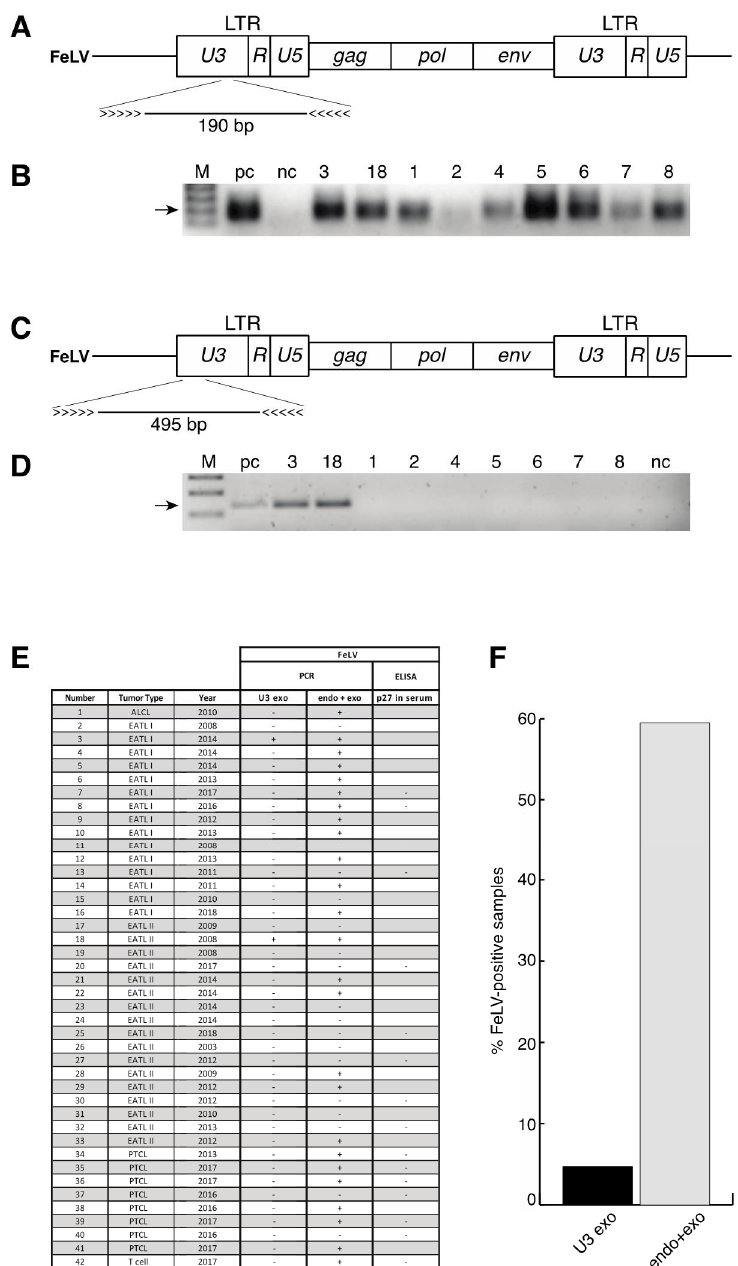
Figure 6. No accumulation of active FeLV among tumour samples. ( A ) Scheme of FeLV structure and location of the primers in the U3 region used for detection of endogenous and exogenous virus sequences. ( B ) Representative images of amplifications of FeLV sequences using primers shown in ( A ). pc = positive control (tissue from a feline patient that was tested positive for FeLV p27 by ELISA) nc = negative control (tissue from a feline patient that was tested negative for FeLV p27 by ELISA) ( C ) Scheme of FeLV structure and location of the primers in the U3 region used for detection of exogenous virus sequences. ( D ) Representative images of amplifications of FeLV sequences using primers shown in ( C ). pc and nc as in ( B ). ( E ) Table summarising the results from the PCR analysis and ELISA. U3 exo corresponds to the detection of exogenous FeLV sequences as in ( C , D ), endo + exo to the detection of endogenous and exogenous sequences as in ( A , B ). The status of p27 was detected in the serum of patients by ELISA as shown in the last row. ( F ) Percentage of samples testing positive for exogenous ( U3 exo ), exogenous and endogenous (endo + exo) FeLV by PCR or for p27 by ELISA among the 42 samples of the cohort. The original images of ( B , D ) can be found in Figure S9.